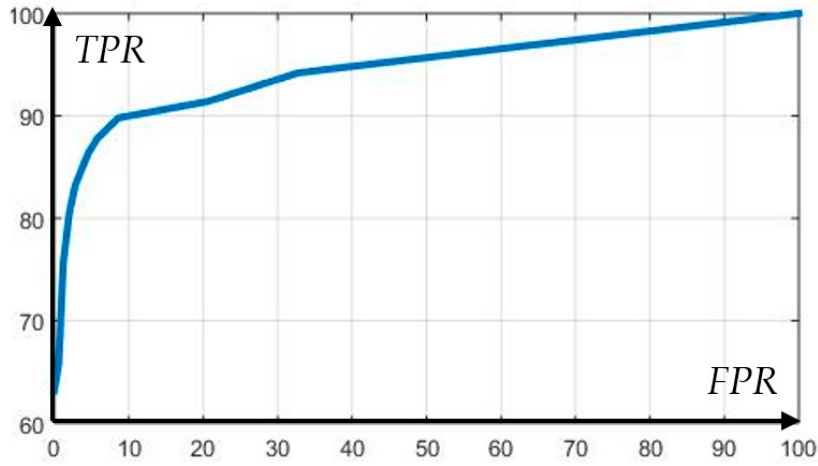
Figure 9. Family of trigger limits obtained at different values of the setpoint p.